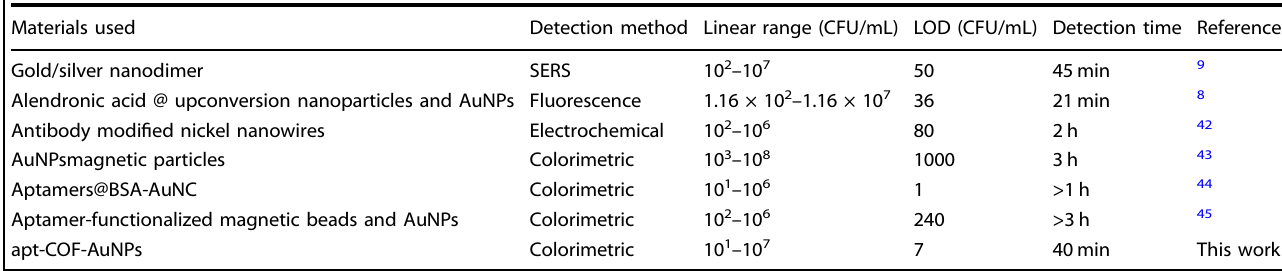
Fig. 6 Proof-of-concept smartphone APP for analysis of S. typhimurium . a Calibration of the smartphone APP by using a standard image, b semi-quantitative analysis of S. typhimurium using a proof-of-concept smartphone APP. All images created by authors. Table 1. A brief overview of recently reported methods for the determination of S. typhimurium .